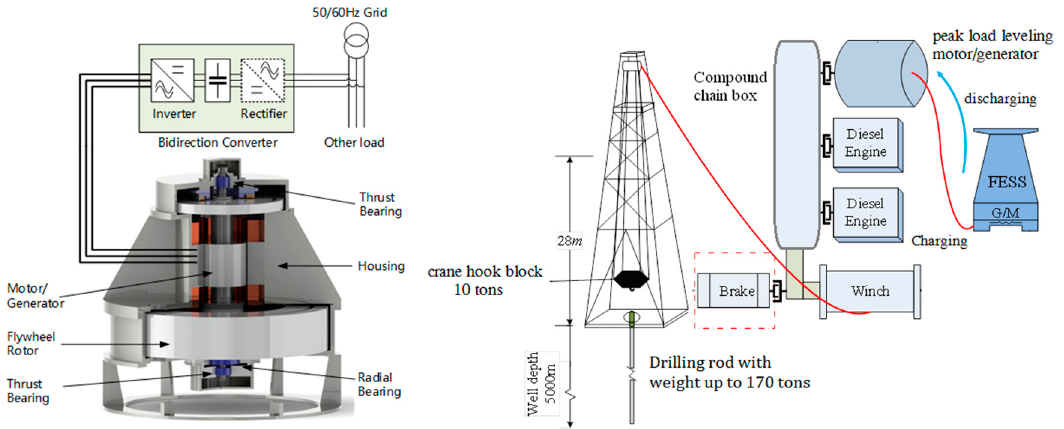
Figure 1. Power system with peak load leveling and braking recovery through flywheel energy storage.